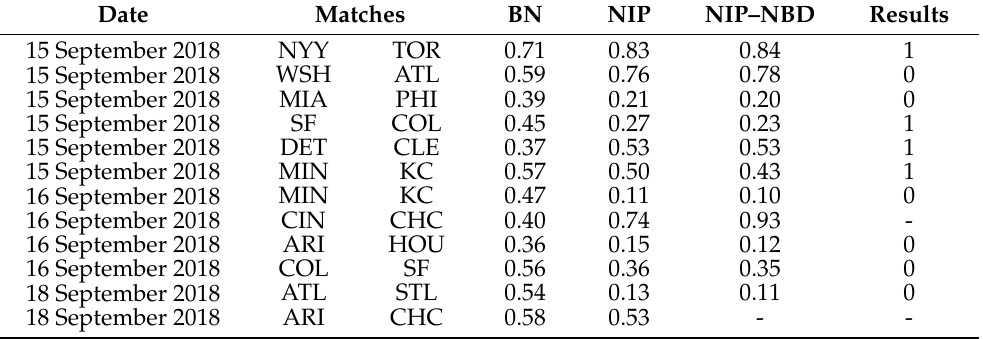
Table A1. Prediction probabilities subject to BN, NIP and NIP–NBD, and real